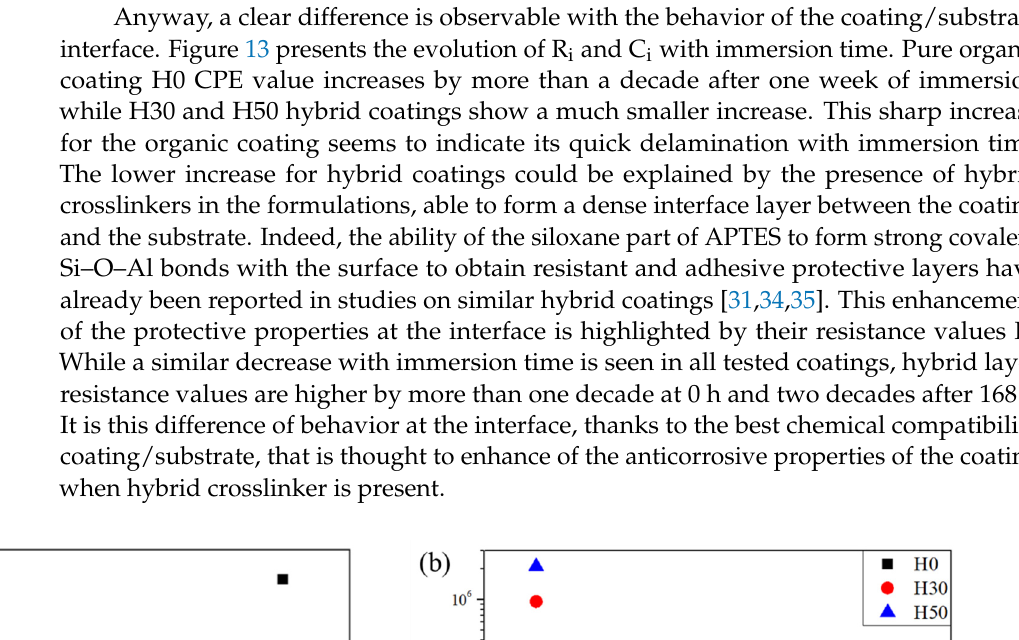
13 of 19 Figure 12. Equivalent circuit models ( a–c ) used for EIS data fitting.